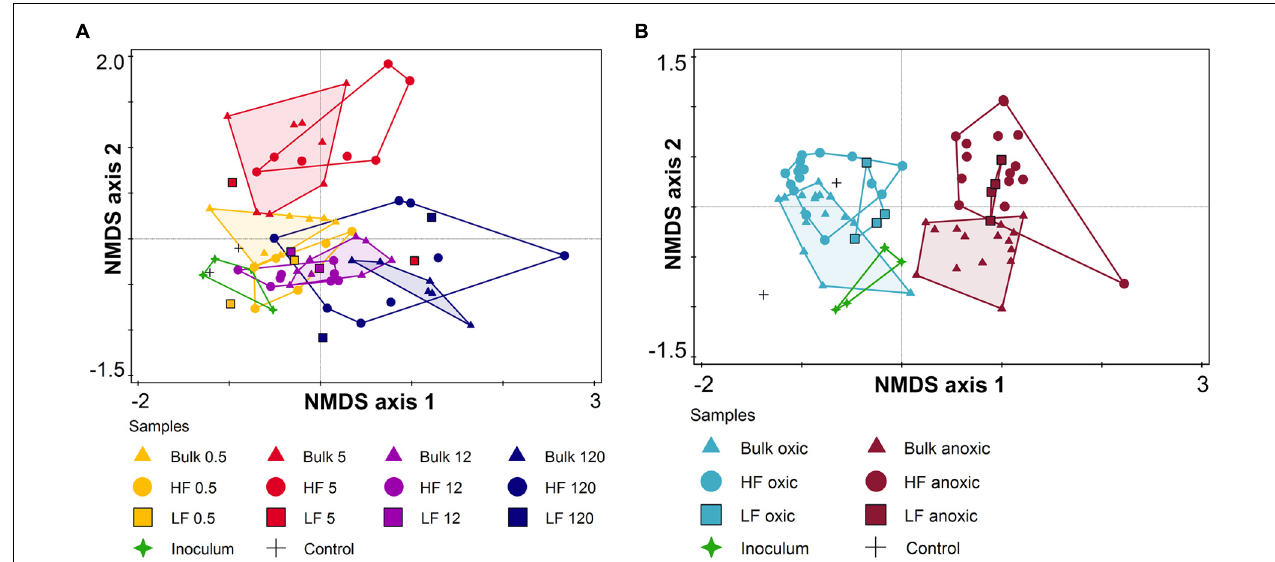
FIGURE 6 | Non-metric multidimensional scaling (NMDS) of (A) archaeal (stress value = 0.218) and (B) bacterial community composition (stress value = 0.133) for the soil microcosm incubation experiment based on relative abundance of T-RFs (after digestion of PCR products with HaeIII) using Bray–Curtis distance measure. Different symbols encode the different soil fractions (triangle – bulk soil; circle – heavy fraction, HF; and square – light fraction, LF). Different colors encode the different soil ages (0.5, 5, 12, and 120 kyr) for archaeal community analysis (A) and O 2 status (oxic and anoxic) for bacterial community analysis (B)